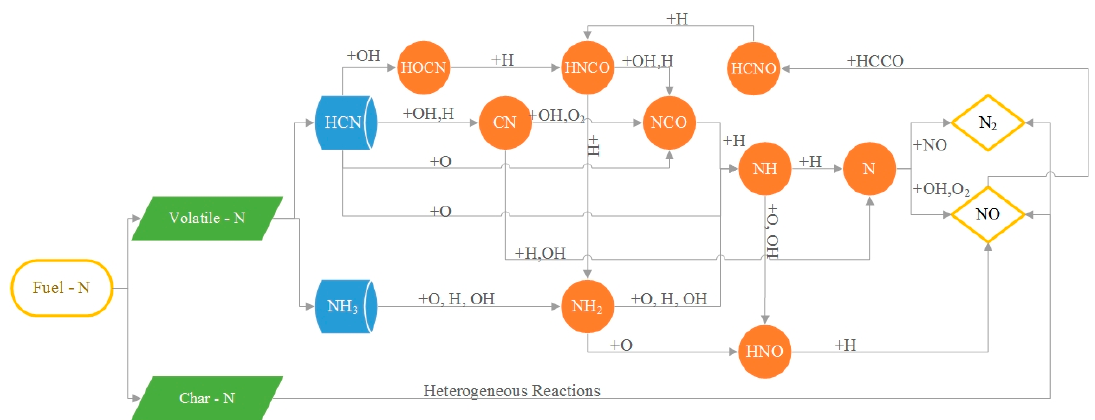
Figure 2. Reaction mechanism – Fuel inherent nitrogen conversion to NO and N 2 Adapted from [46].